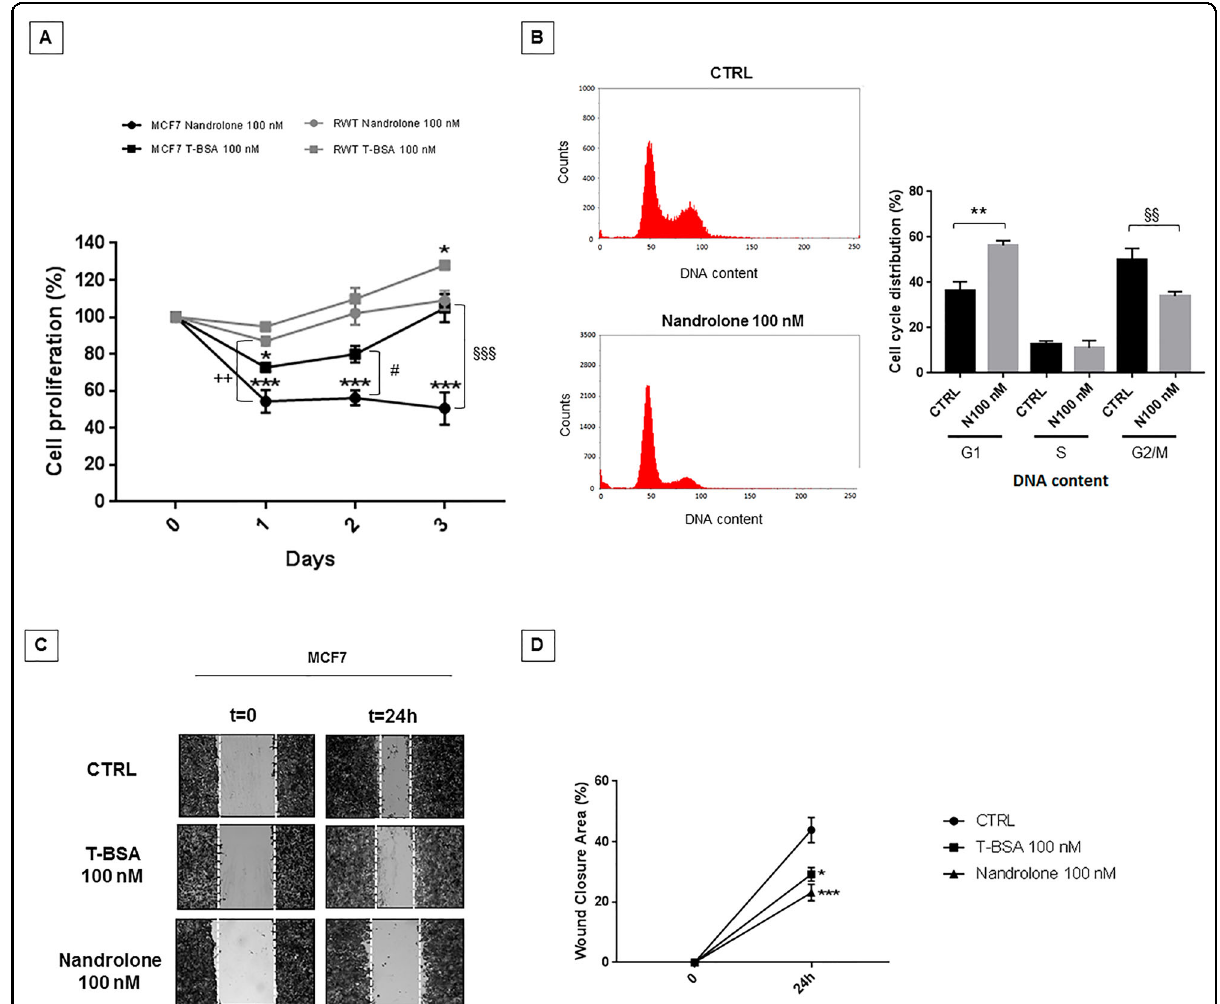
Fig. 3 Nandrolone signi fi cantly reduces cell proliferation and migration. A MTT assay on MCF7 wild-type cells or over-expressing RACK1 (RWT) was performed to evaluate cell proliferation following 100 nM of testosterone-BSA-FITC (T-BSA) or nandrolone treatment for different timings (1, 2, and 3 days). Cells were treated at t = 0 and vehicle controls with DMSO < 0.1% (CTRL). Value bar in the graph represents the mean ± SEM of four independent experiments. The analysis was performed by two-way ANOVA with Tukey ’ s multiple comparisons test with * p < 0.05, ** p < 0.01, *** p < 0.001 vs t = 0, # p < 0.05 vs T-BSA at t = 2, §§§ p < 0.001 vs T-BSA at t = 3, ++ p < 0.01 vs RWT at t = 1. B Effect of 100 nM Nandrolone treatment on the phases of the cell cycle. MCF7 cells were grown in complete medium and starved for 24 h. After 24 h of starvation, MCF7 cells were grown for 24 h in complete medium and then treated with DMSO < 0.1% (CTRL) or with 100 nM Nandrolone (N100 nM) for 24 h. The percentage of cells in each phase of the cell cycle was determined by fl ow cytometry after 24 h. The results are shown as the percentage of cells in each phase of the cell cycle. Data were expressed as mean ± SEM. from three independent experiments. The analysis was performed with Bonferroni ’ s multiple comparisons test, with ** p < 0.01 vs CTRL G1, §§ p < 0.01 vs CTRL G2. C – D Effect of testosterone-BSA-FITC or nandrolone on MCF7 cells migration by scratch wound healing assay, performed as described in materials and methods. MCF7 cells were cultured with DMSO < 0.1% (CTRL) or with 100 nM of T-BSA or nandrolone and subsequently migration was analyzed at 24 h. C The image is a representative result. D Value bars in the graph represents the mean ± SEM of three independent experiments, in duplicate. The analysis was performed by two-way ANOVA with Tukey ’ s multiple comparisons test with * p < 0.05, *** p < 0.01 vs